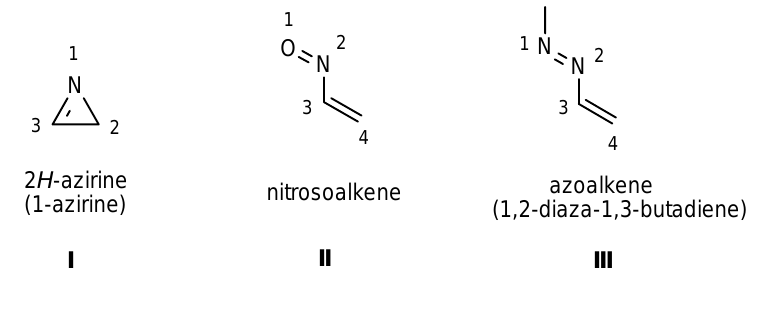
Figure 1. Name, structure and numbering of